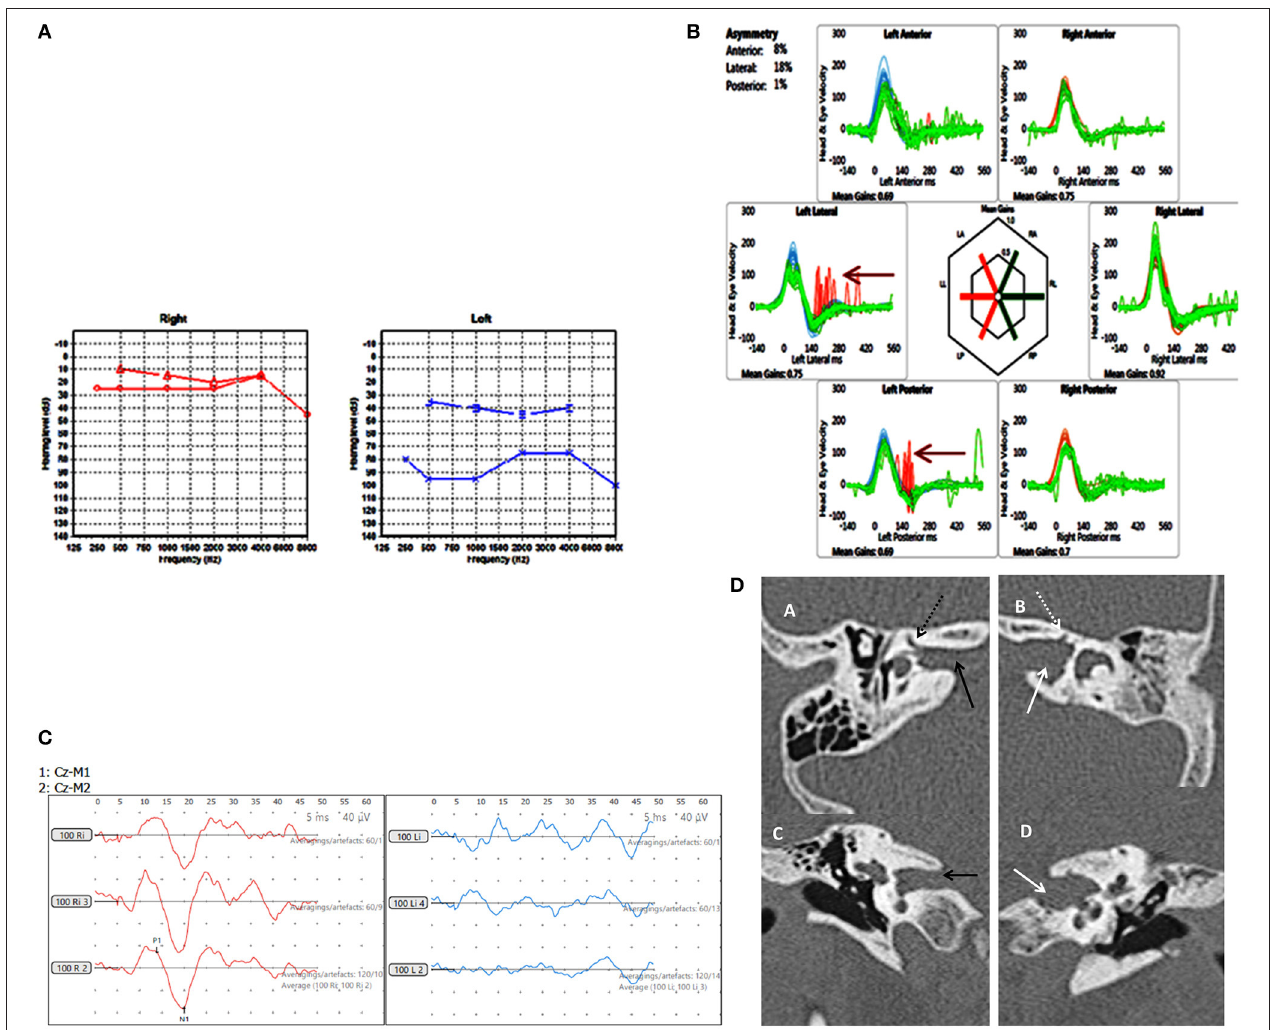
FIGURE 4 | Case number 8, Multiple abnormalities. (A) , Pure tone audiometry showing left mixed hearing loss (A) with a normal right side. (B) , vHIT showing left sided high frequency multiple canal dysfunction with catch up saccades (arrow) with a normal right side. (C) , No response on the cVEMP on the left with a normal right side. (D) , CT scan of the left petrous temporal bone in the axial plane (B) and coronal plane (D) demonstrate irregular widening of the internal auditory canal (white arrow) the labyrinthine segment of the left facial nerve canal has an ill-defined bony wall (dotted white arrow). The right petrous temporal bone demonstrates a normal sized internal auditory canal (C black arrow) on the axial and coronal planes and the bony wall of the right facial nerve canal appears normal (A dotted black arrow).